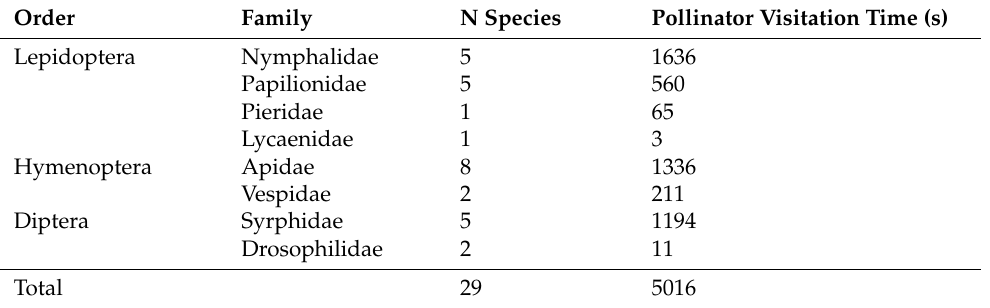
Table 1. Number of pollinator species identified in 42 coffee fields in Cipaganti and